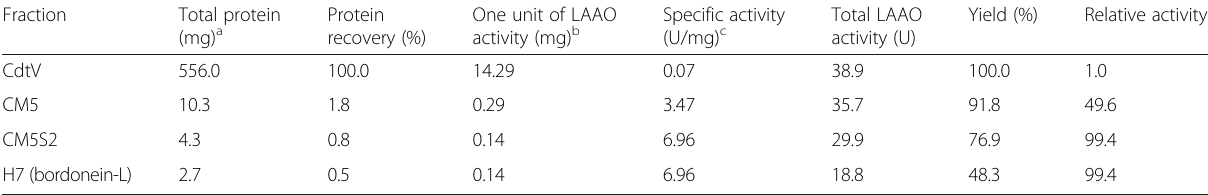
Table 1 Specific activity and recovery of active fractions eluted during the purification procedure of bordonein-L Fraction Total protein Protein One unit of LAAO Specific activity Total LAAO Yield (%) Relative activity (mg) a recovery (%) activity (mg) b (U/mg) c activity (U) CdtV